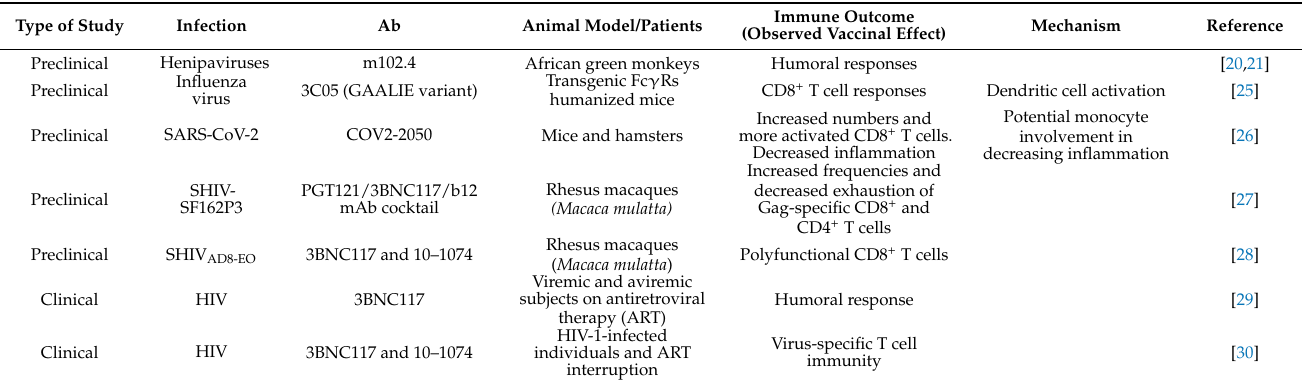
Table 1. Vaccinal effects reported in preclinical and clinical studies of human viral